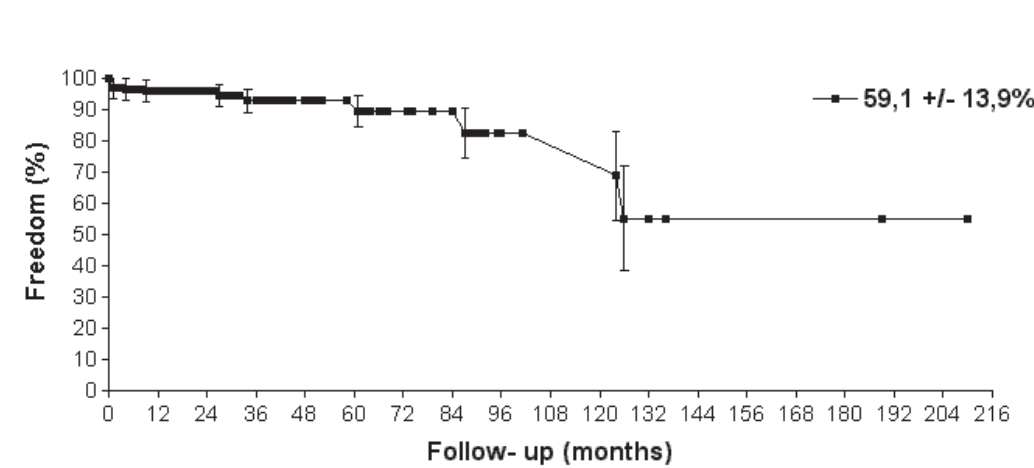
Figure 3 - Actuarial freedom from reoperation (% +/- Standard Error)